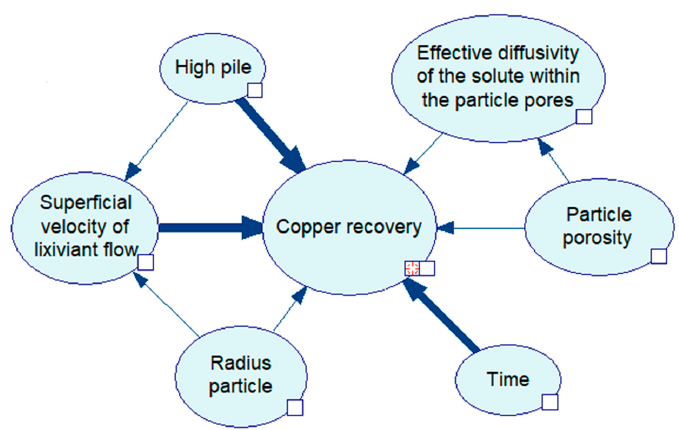
Figure 5. Bayesian network for copper heap leaching process incorporating a priori knowledge.